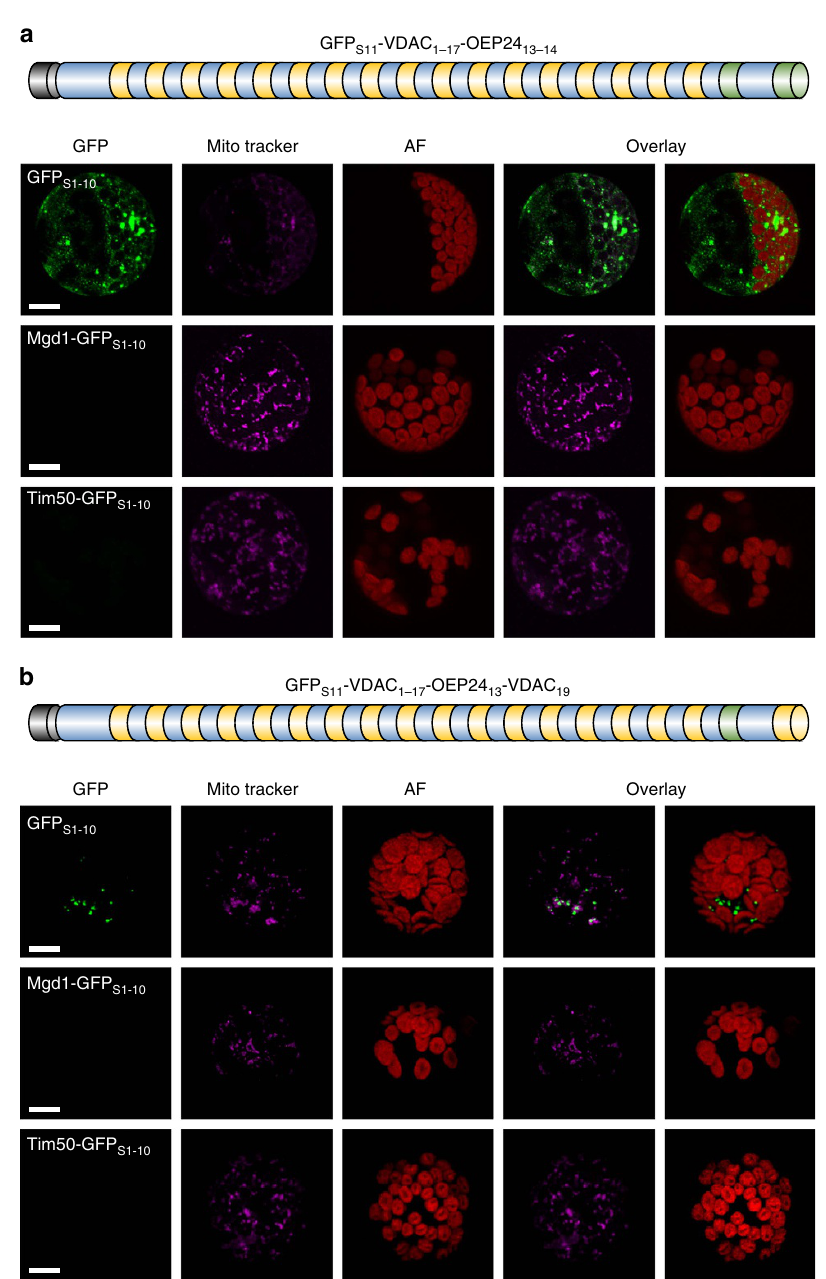
Figure 5 | The last b -hairpin of atVDAC1 is important for mitochondrial targeting. ( a , b ) GFP S11 -VDAC 1–17 -OEP24 13–14 ( a ) or GFP S11 -VDAC 1–17 -OEP24 13 - VDAC 19 ( b ) and the indicated reporter constructs were co-transformed into A. thaliana protoplasts. Signals and schemes are as in Fig. 3a. Scale bar, 10 m